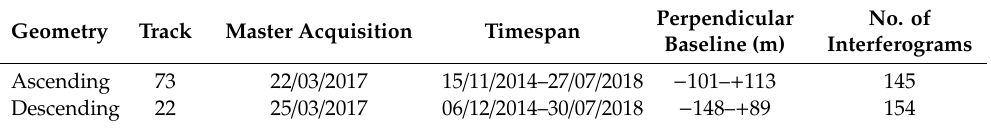
Table 1. Sentinel-1 data used in the